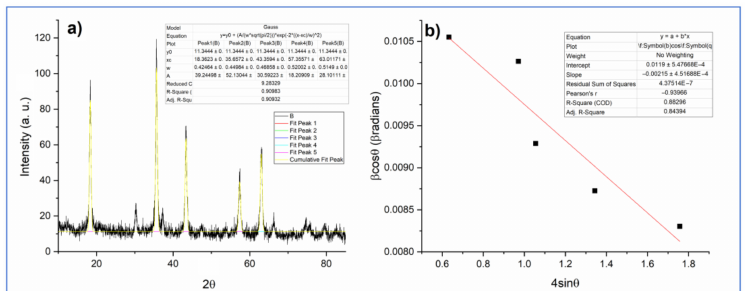
Figure 3. Peak fitting by using a Gaussian function ( a ) and Williamson–Hall plot ( b ) for the MgCr 2 O 4 _HMTA sample.